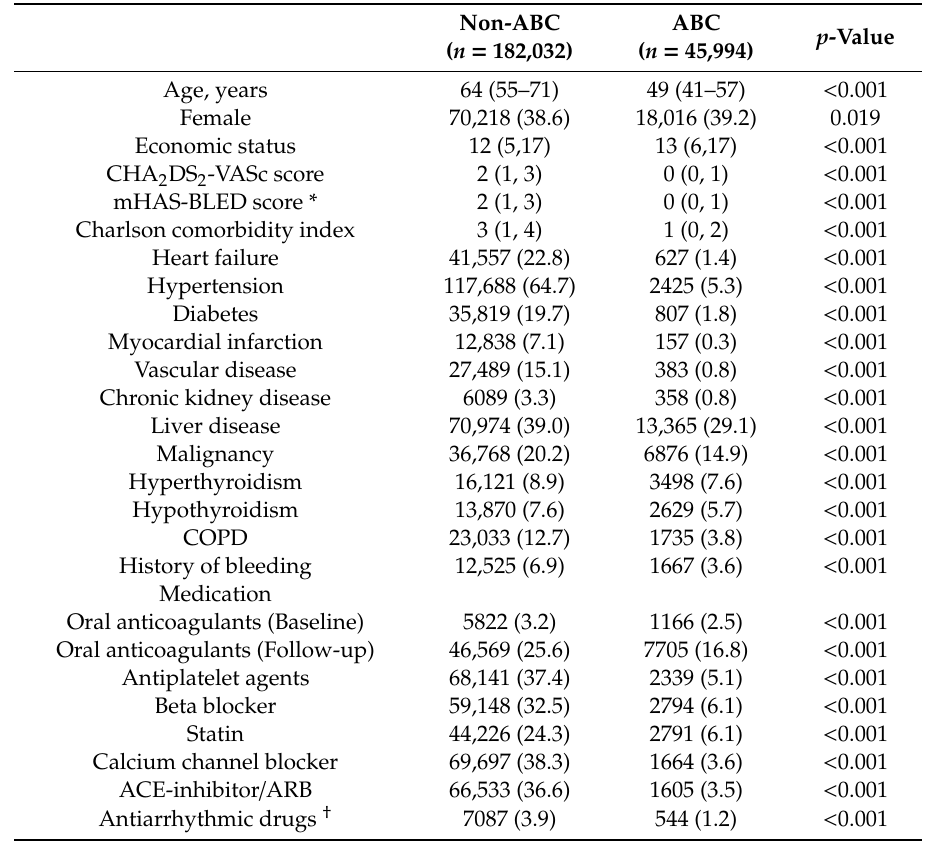
Table 1. Comparison of clinical characteristics between atrial fibrillation patients compliant with and without the atrial fibrillation Better Care (ABC)